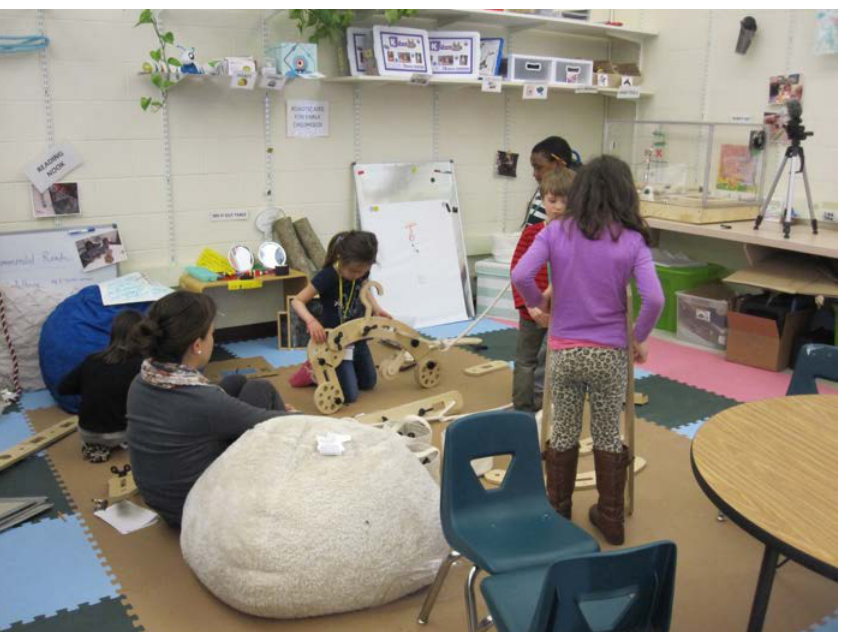
Figure 5. Children built constructions for injured or disabled people, including crutches (foreground right) and a pull-along wheelchair (background center), while Teacher 3 (left) observes